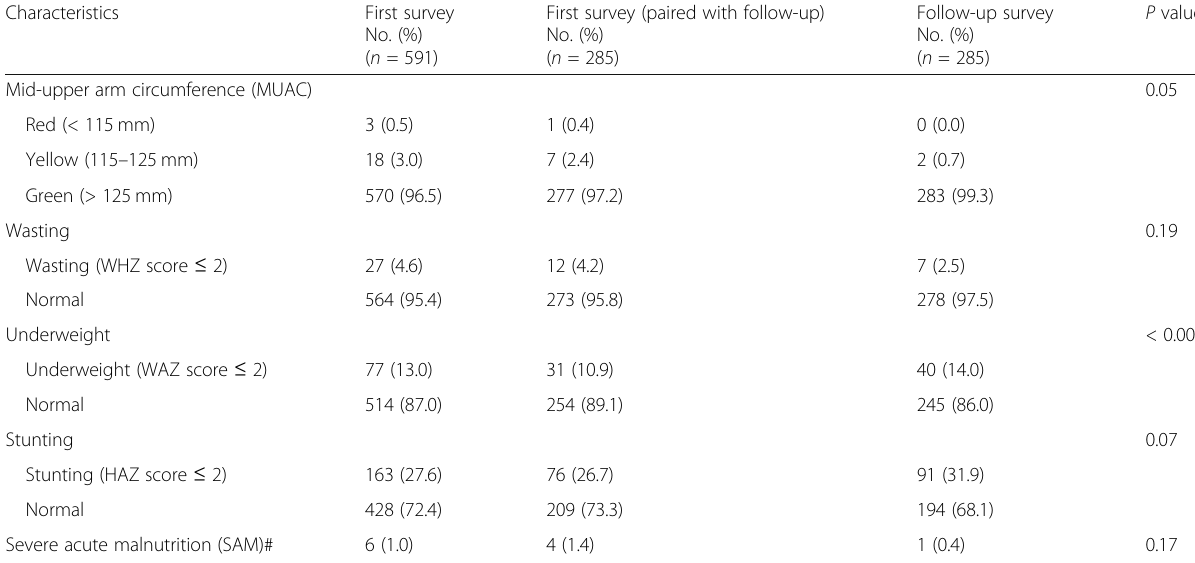
Table 2 Characteristics of nutritional status of children in the first and the follow-up surveys Characteristics